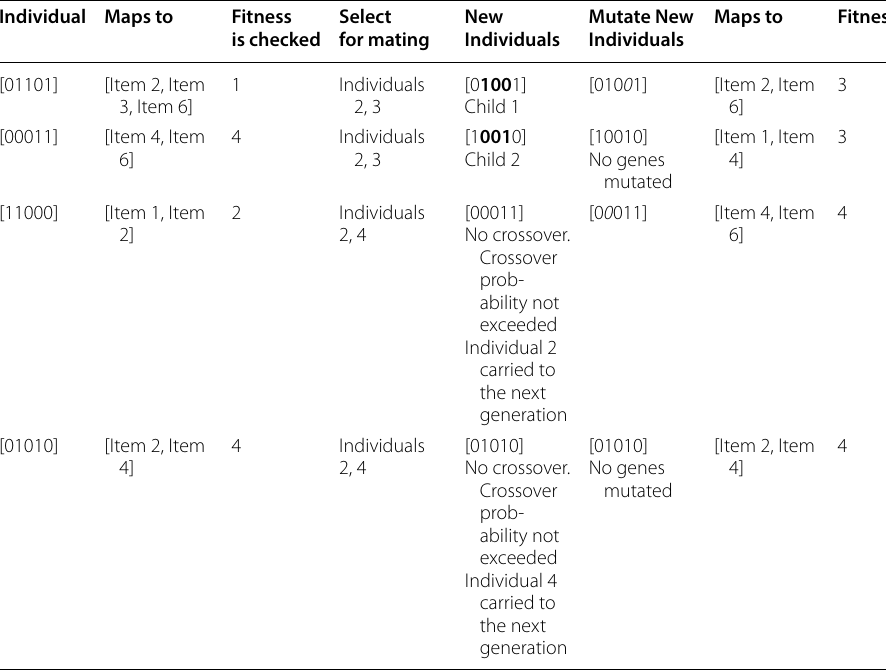
Table 2 Genetic algorithm example Individual Maps